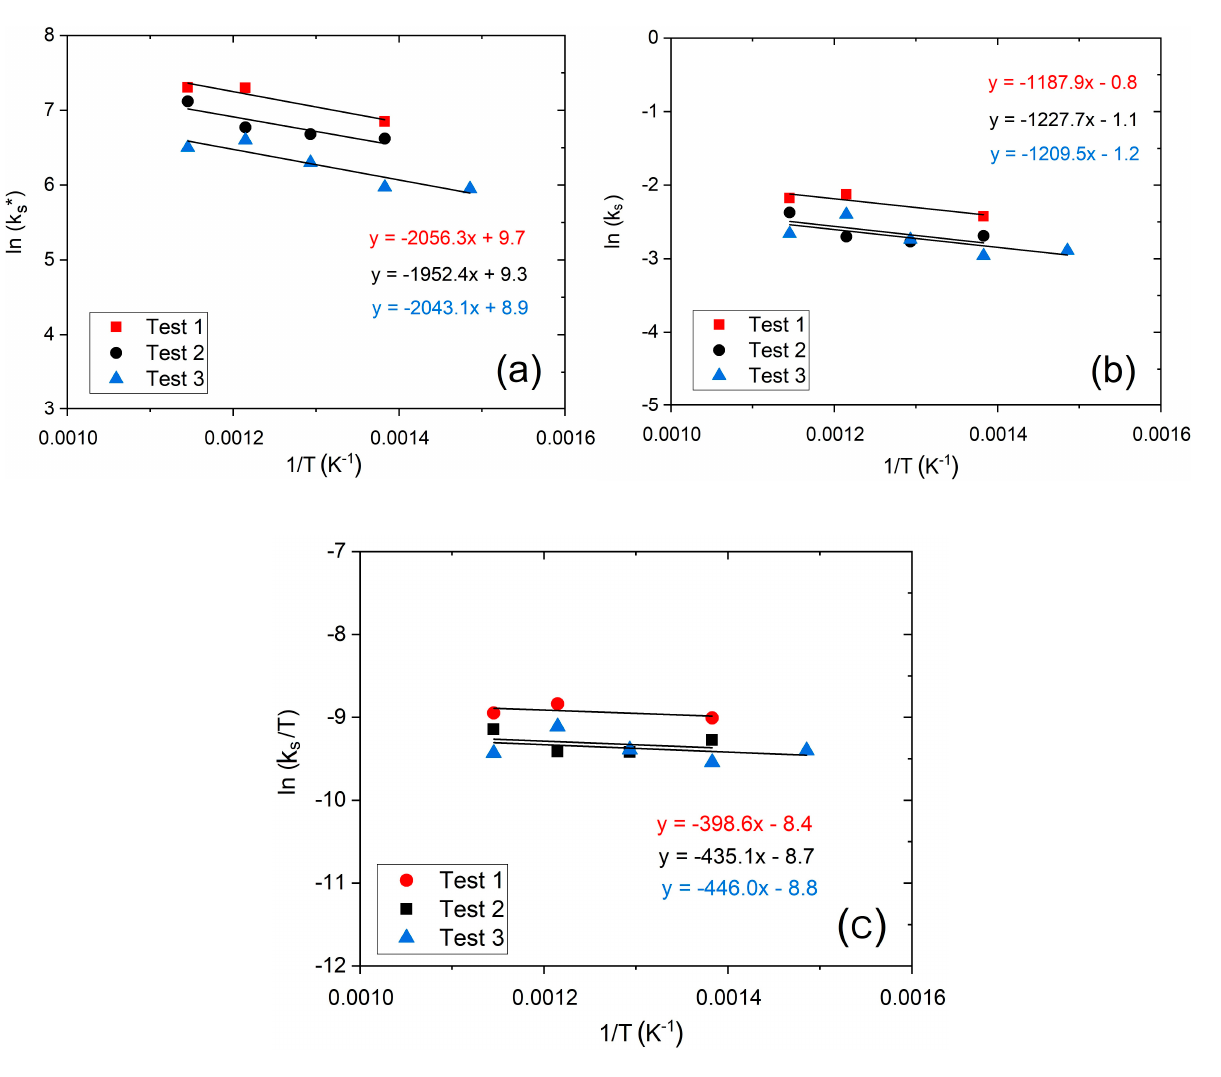
Figure 6. Arrhenius plots in terms of ( a ) k ∗ s and ( b ) k s ; ( c ) the Eyring–Polanyi representation plotting ln(k s /T ) vs. the reciprocal temperature. Test 1 (red circle) corresponds to experimentation using syngas, 1.5 cm LB bed length, and GHSV equal to 50,000 h − 1 ; Test 2 (black square) involves the investigation using syngas, 0.8 cm LB, and GHSV equal to 25,000 h − 1 ; Test 3 (blue triangle) is associated with humid hydrogen, 1.5 cm LB, and GHSV equal to 25,000 h − 1